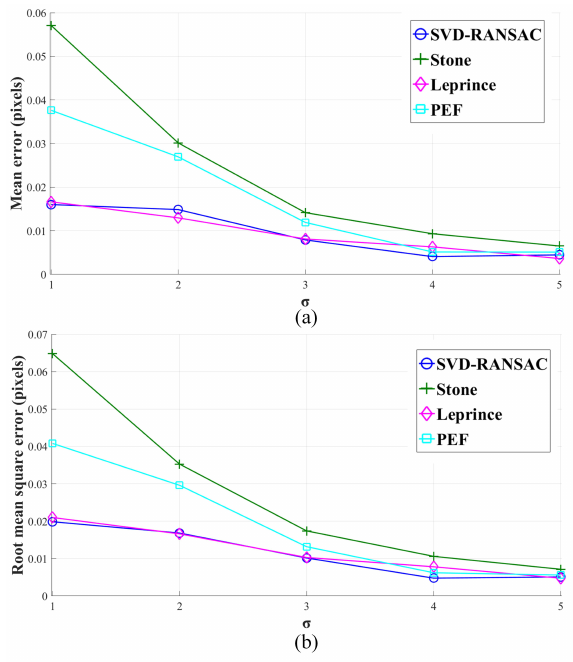
Figure 6. Results of the Aliasing experiment: (a) MV and (b) RMSE.